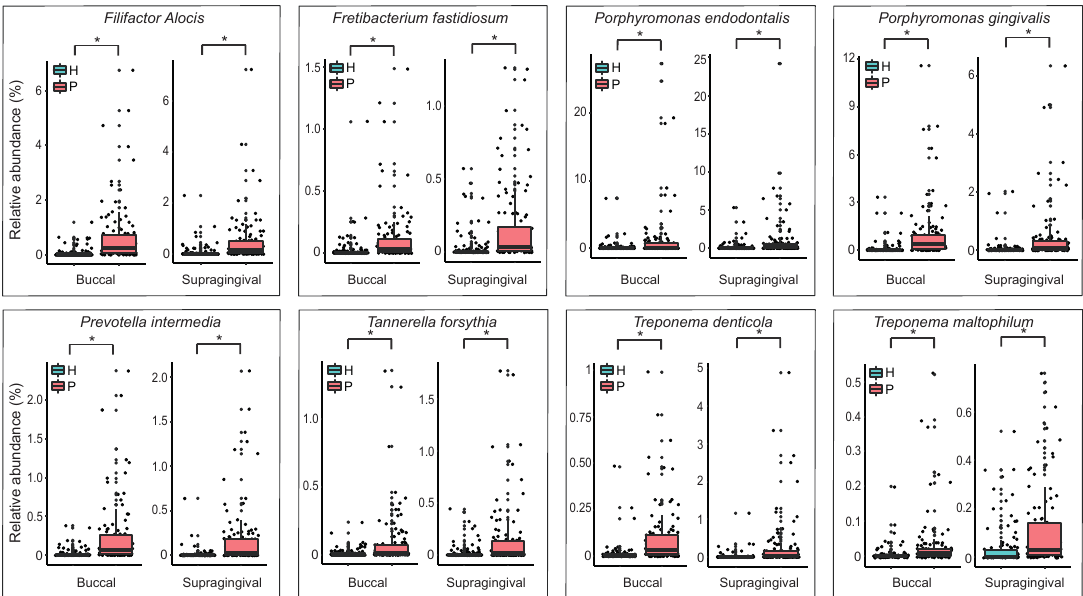
Figure 5. Clinical validation of the identified microbiome related to periodontitis. Real-time PCR (RT-PCR) was performed to measure a relative abundance of bacterial species in the sample. The di ff erence between two groups (H: healthy group, P: periodontitis group) was assessed using the Wilcoxon rank sum test. The * indicates that the p-value for the test is less than